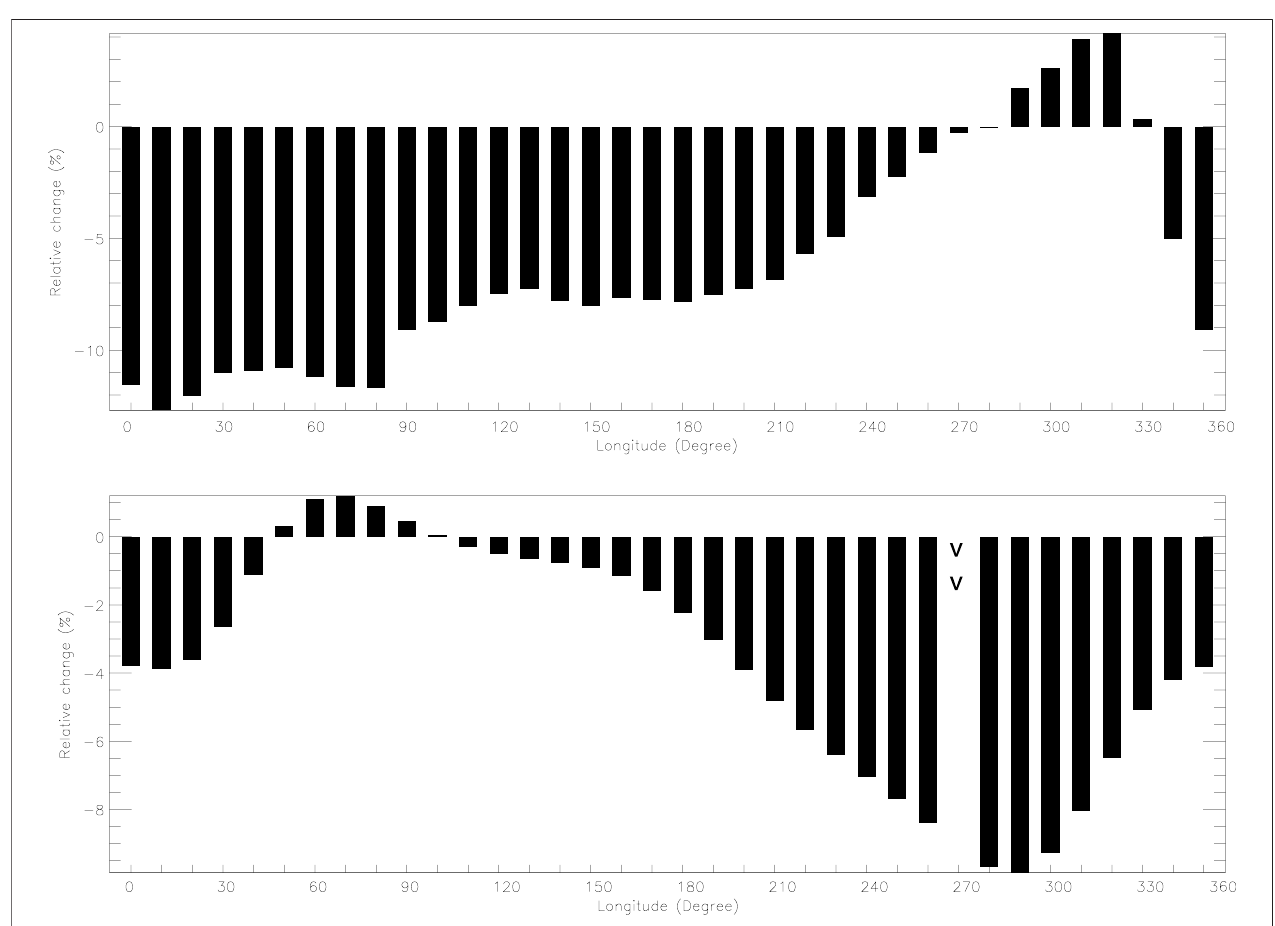
FIGURE6| Histogramofvariationofbackgroundgeomagnetic fi eldandcutoffrigiditieswiththelongitudebetween1965and2025.Theupperpanelindicatesthat the relative change of the magnetic fi eld changes with the longitude, and the lower panel indicates the relationship between the relative change of cutoff rigidities and